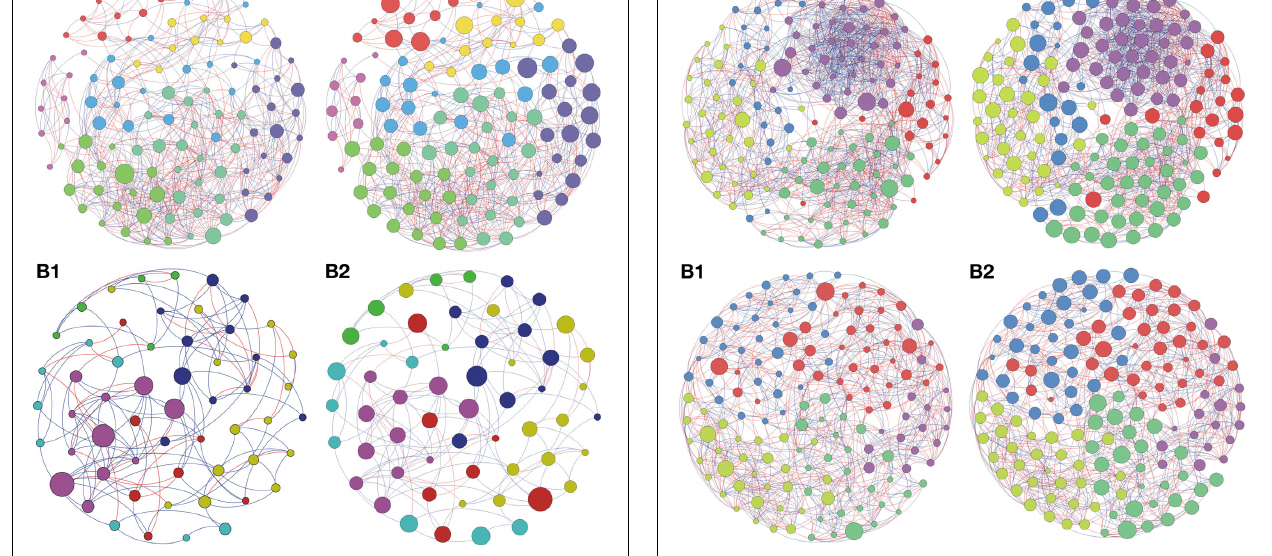
FIGURE 1 | Network interactions of soil bacterial genus found in Acacia plantation (A1, A2) and in the Soybean plantation (B1, B2) from site A on Pampa biome. A connection stands for a strong Pearson’s correlation ( p ≥ 0 . 9 and P -value ≤ 0.05). Each circle (usually called node) represents a bacterial genus and the sizes of the circles are proportional to the value of betweenness centrality in (A1) and (B1) . In (A2) and (B2) the sizes of the circles are proportional to value of closeness centrality. Lines connecting two bacterial genera represent the interactions between them. Blue lines represent the positive significant correlations and red lines represent a negative significant correlation. The colors of the circles represent the bacterial modules. For clarity, the OTU’s identity was omitted. Detailed networks containing the identity of each node can be observed in the Supplementary Figures S1–S5 and Supplementary Table S1.